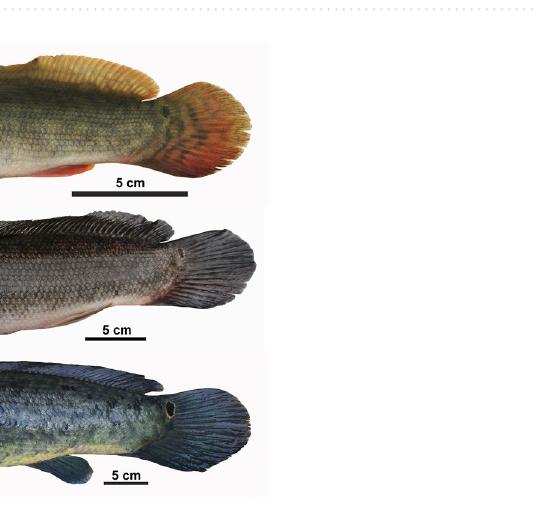
Figure 4. ( a ) PC projections of PCs 1–3, dots are colored according to the population designation determined with hierBAPS. ( b ) Manhattan plot showing all SNPs, significance as determined by the Bonferroni method is demarcated in red. ( c ) Gene ontology analysis, number of sequences related to the three hierarchal categories and their sub-classes are shown.